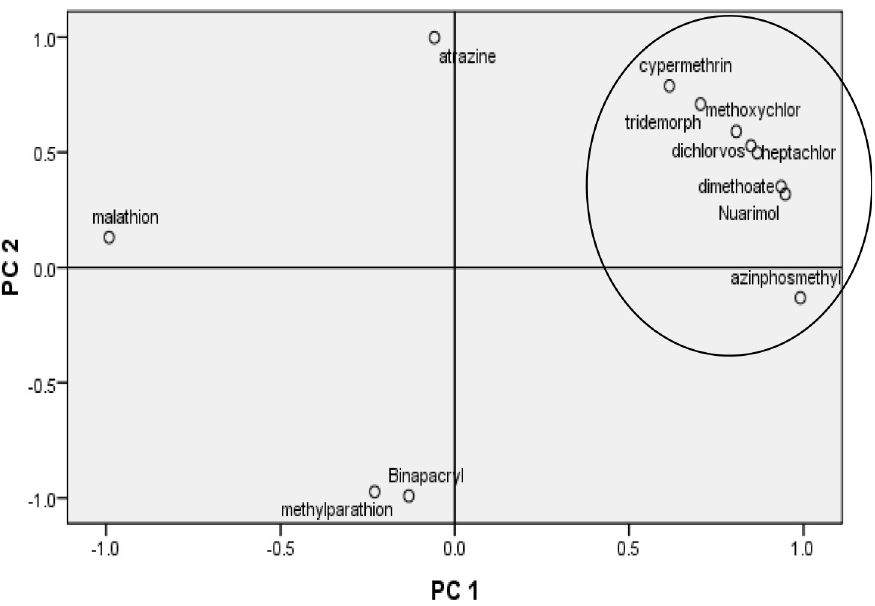
Fig 5. Principal component plot of pesticide residues in sediment samples from river Ganga. The determination of carcinogenic and non-carcinogenic risk associated with pesticide exposure from sediments includes three routes. The non-carcinogenic risk estimation from the three stations (Tables 1, 2 and 3) were below the reference levels (USEPA) for each studied pesticide, therefore these contaminants are unlikely considered to pose potential risk to human health [69]. According to the USEPA, guidelines if the estimated CDI value of pesticide exceeds oral reference dose (S3 Table, USEPA) value is supposed to pose adverse health impact or non-carcinogenic risk to human health. The estimated CDI value for each pesticide showed that children are at higher risk than adults. Ogbeide et al . [34] have reported similar results for CDI values from Illushi River, Ogbesse River and Owan River of Nigeria. Carcinogenic risk from the exposure of pesticides in sediments was below the threshold limit of 10 − 6 (USEPA) indicating no observed risk for both adults and children population groups at each station. Estimated results for non-carcinogenic and carcinogenic risk showed, pesticide exposure from the inhalation route has higher potential to cause risk in adults and children than by other two routes. Further, the study also clarifies that there is a higher potential of cancer risk through multiple exposure routes in children than in adult population